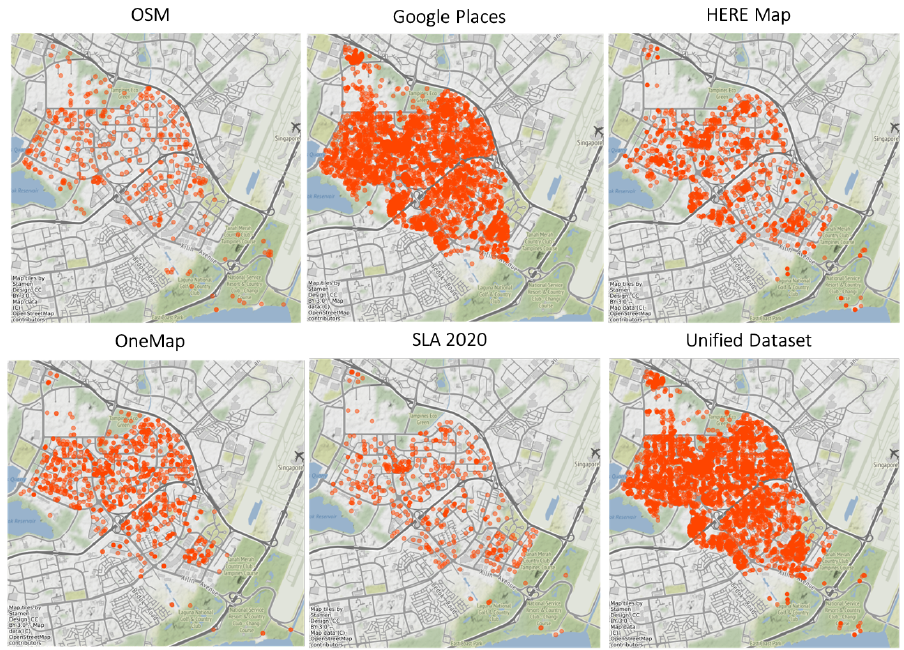
Figure 6. The geographical distribution of the POIs from different data